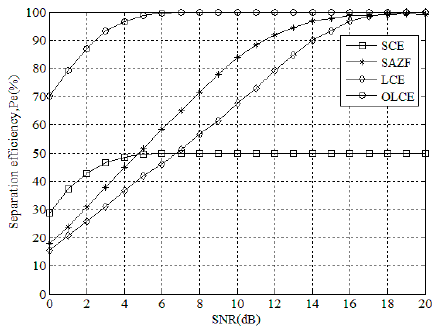
Figure 6. Separation efficiency for SCE, SAZE, LCE, and OLCE under different SNR when the number of collided tags is two.